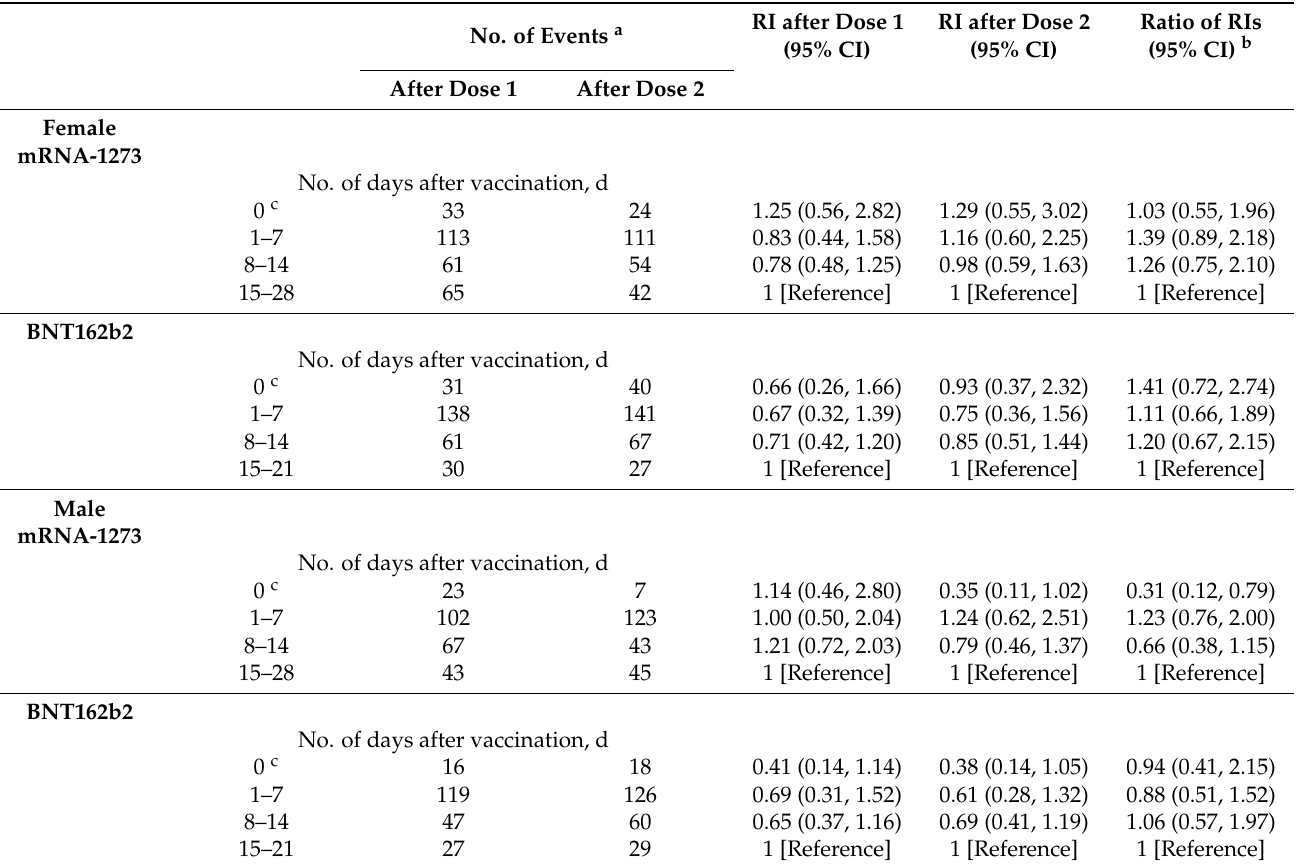
Table 3. The ratios of relative incidences and relative incidences of venous thromboembolism after two doses of COVID-19 vaccination, stratified by reported